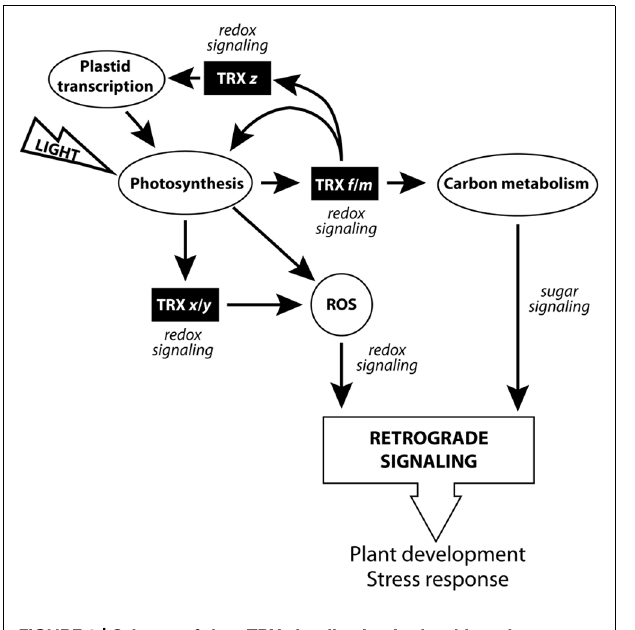
FIGURE 3 | Scheme of the pTRXs implication in the chloroplast signaling